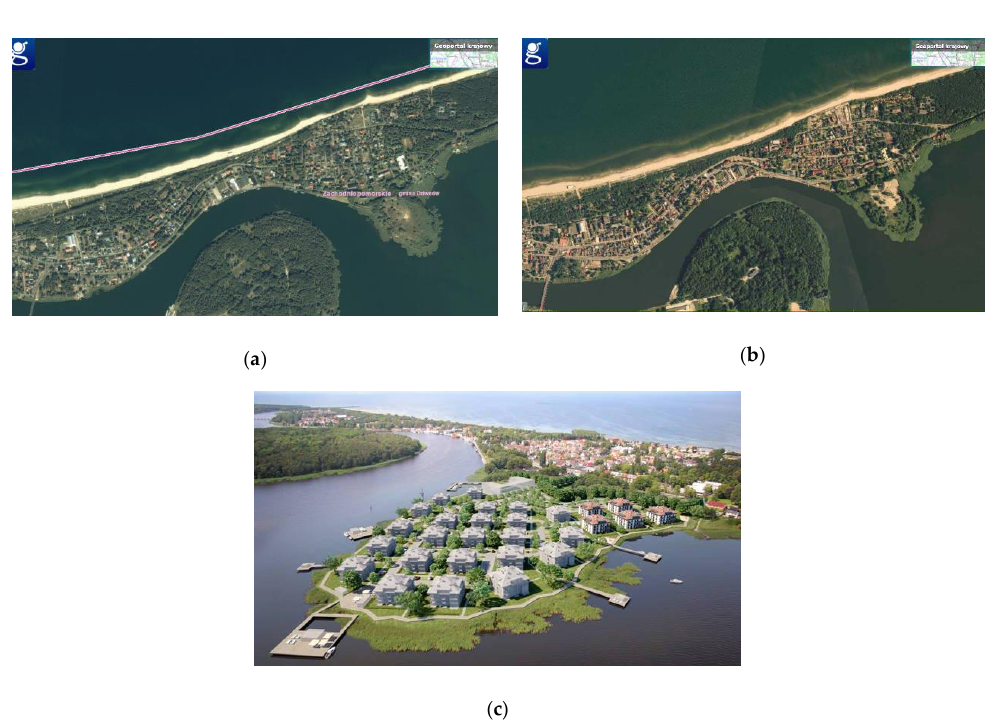
Figure 9. Dziwnow, the coastal resort in the Szczecinski region, 0.25 m aerial ortoimagery from geoportal.gov.pl: ( a ) 2005; ( b ) 2018; ( c ) planned, until 2020, development the Dziwnow peninsula.